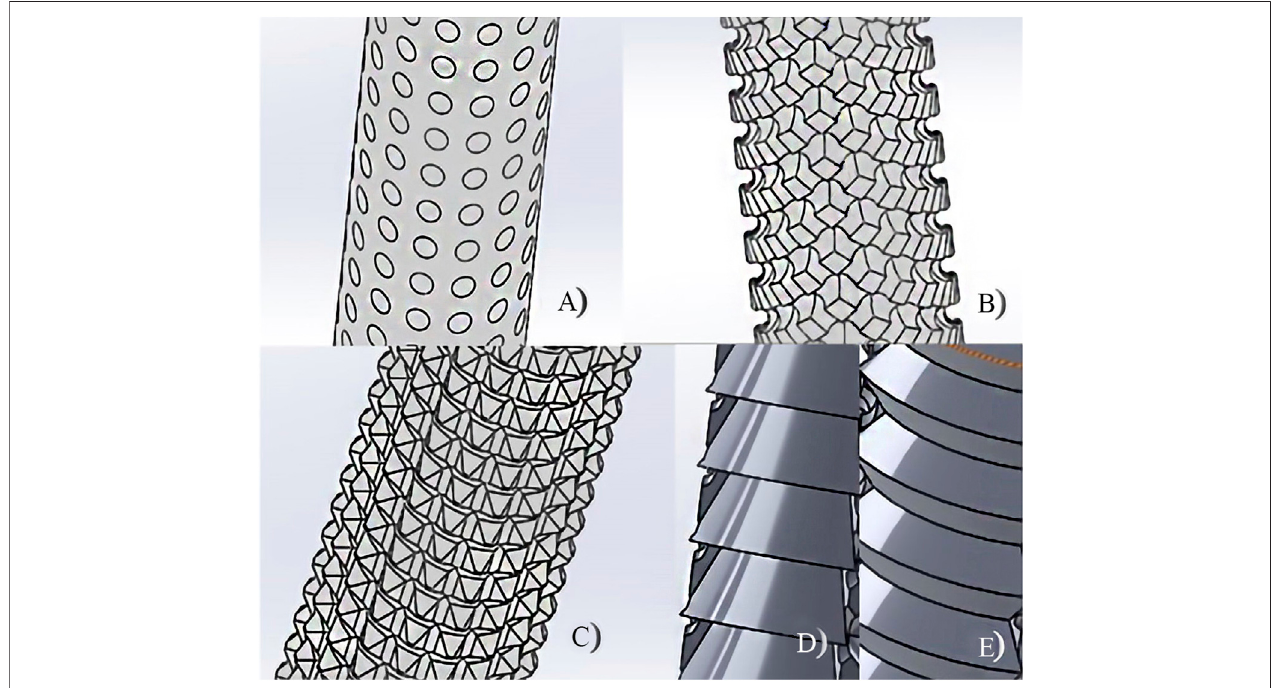
FIGURE 2 | Different surfaces of the PEEK-plug stem: (A) macroporous holes, (B) cylindrical holes, (C) prismatic holes, (D) fl anges, and (E) ridges.